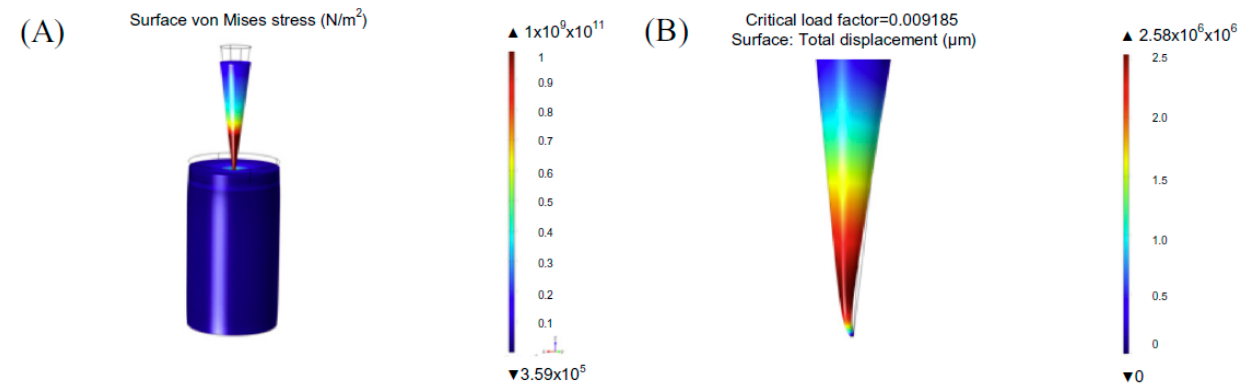
Figure 9. Finite element analysis of a CMC/maltose microneedle with a conical shape. ( A ) Surface von Mises stress when an axial load of 5 N is applied on the base. ( B ) Prediction of bucking mode when an axial load of 5 N is applied at the base and a fixed constraint is forced at the tip [306].